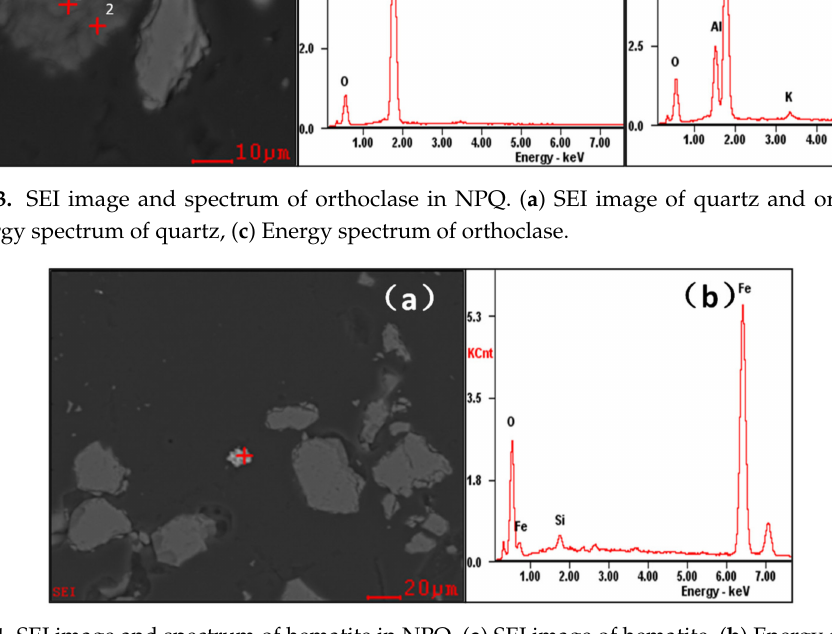
Figure 4. SEI image and spectrum of hematite in NPQ. ( a ) SEI image of hematite, ( b ) Energy spectrum of hematite. Table 3. Distribution of Al 2 O 3 and Fe 2 O 3 at different minerals in NPQ detected by MLA (%).